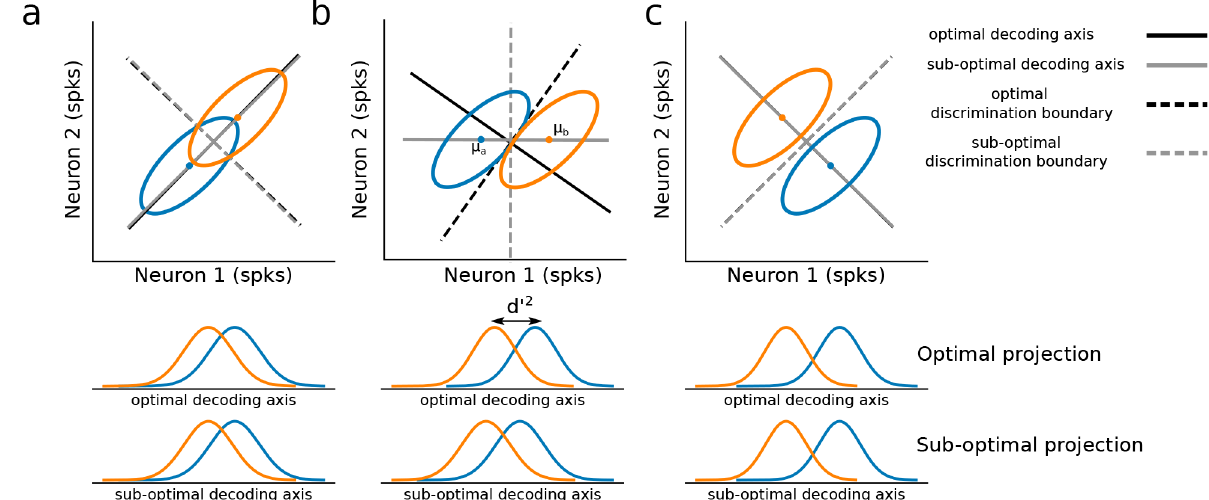
Fig 1. Neuronal noise correlation and population coding. a.-c . In each panel, the spiking responses of two neurons are simulated for two experimental conditions (blue vs. orange). Noise correlation strength and the absolute distance between the mean responses were fixed across all simulations. Top: Response distributions in state-space under each condition are summarized using an ellipse that shows one standard deviation of responses around the mean. Middle: Responses are projected onto the optimal linear decoding axis, where decoding metrics such as d 0 2 can be visualized and measured. d 0 2 quantifies how discriminable two Gaussian distributions are. Bottom: Responses are projected onto a sub-optimal decoding axis. Unlike the optimal axis, this does not take into account noise correlations. Figure is adapted from Averbeck & Lee, 2006 [6].